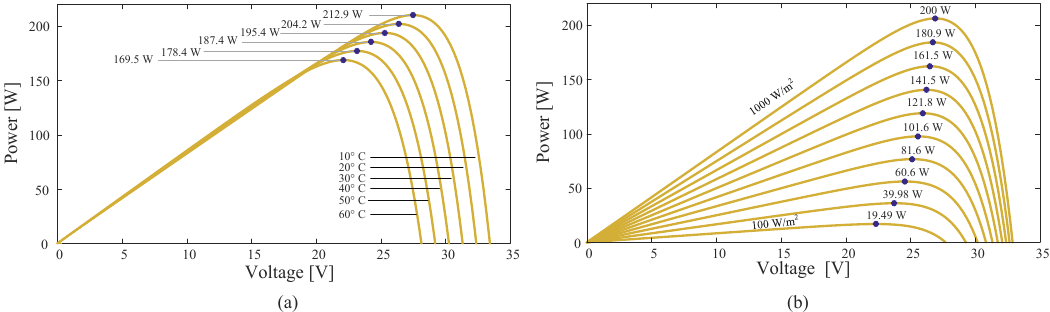
Figure 3. The P-V under variable conditions: ( a ) Under different temperature degrees. ( b ) Under different solar irradiance levels.